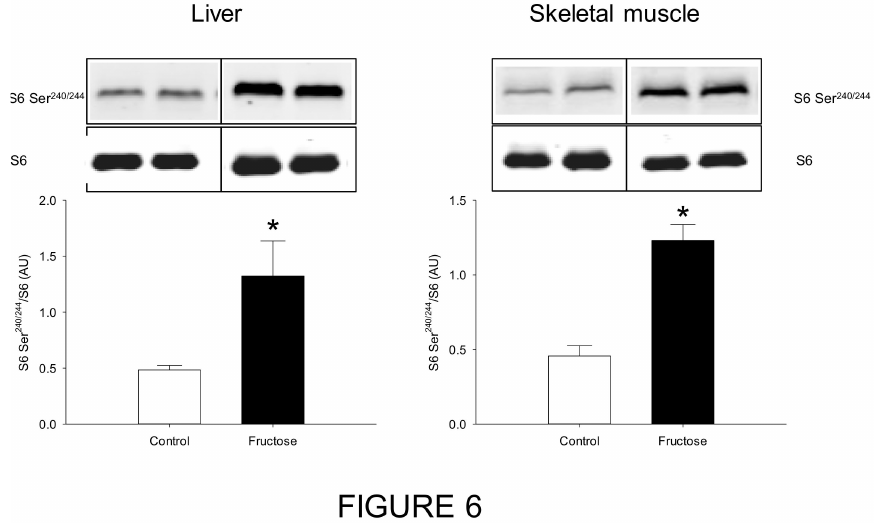
Figure 6. Representative Western blot analyses of S6 protein complex phosphorylation status (S6 Ser 240/244 /S6) in the liver and skeletal muscle of rats fed a control or high-fructose diet during 45 days. Data is presented as mean ± SEM ( n = 8). * represent significant ( p < 0.05) differences between groups. Table 2. mRNA levels of protein and transcription factors involved in BCAA metabolism regulation on the liver and skeletal muscle of rats fed on a regular or high-fructose diet for 45 days.